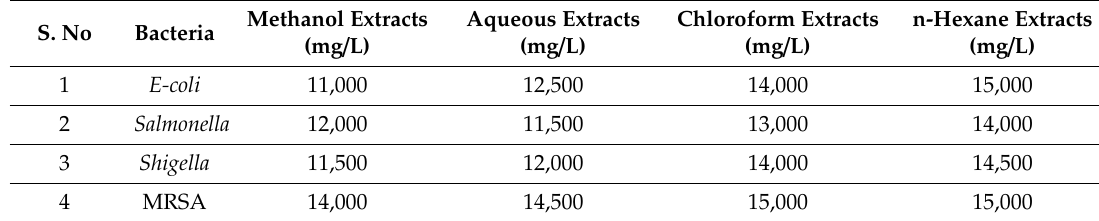
Table 6. Minimum inhibitory concentration (MIC) of recipe 1 against di ff erent bacterial strains.